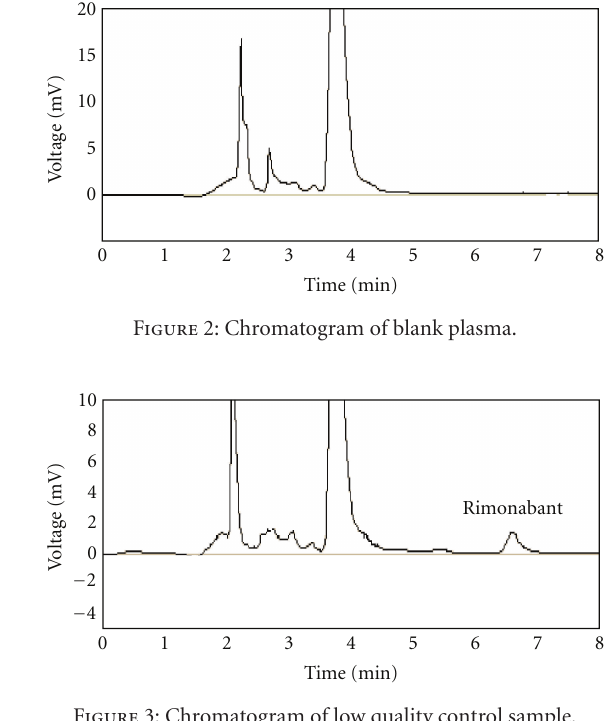
Figure 3: Chromatogram of low quality control